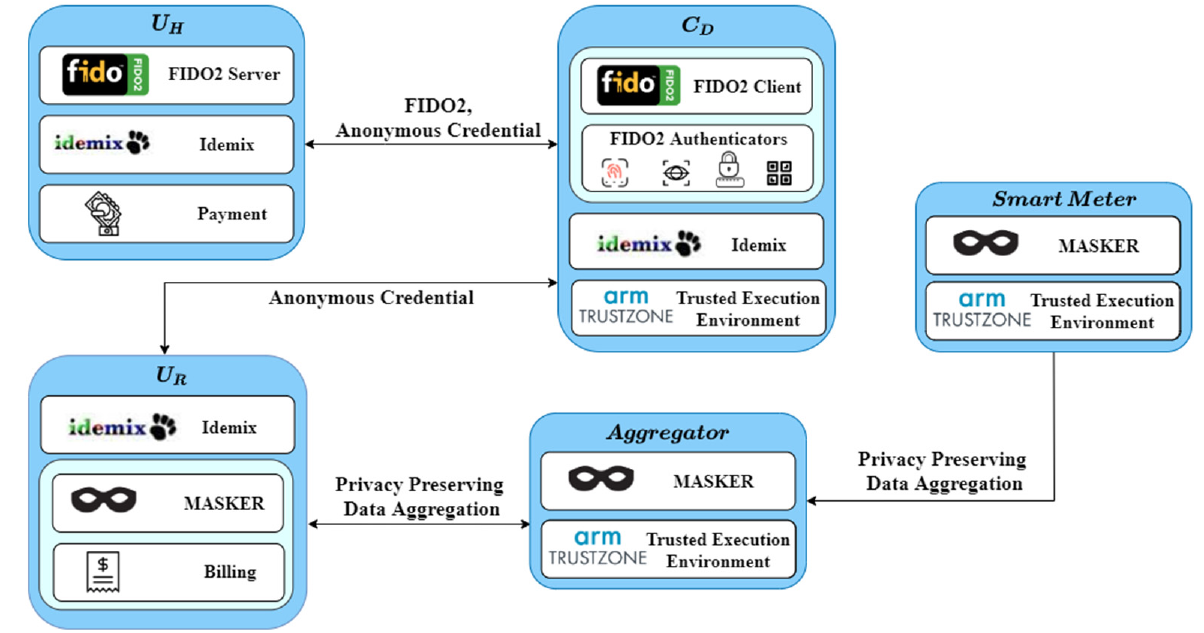
Figure 2. P4G2Go architectural components.